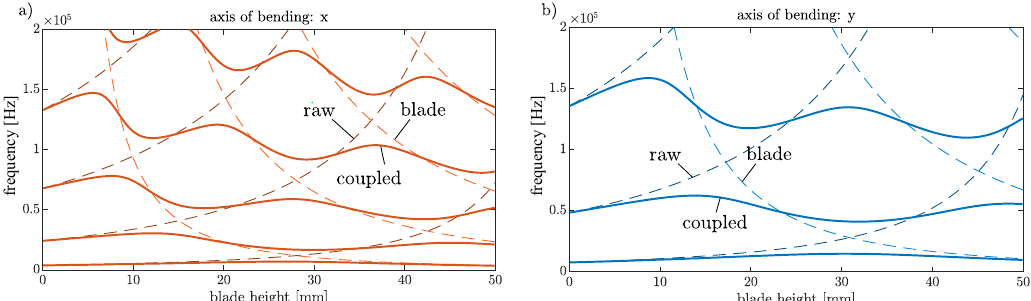
Figure 4. The fluctuation of the natural frequencies in the function of the blade height calculated by the simplified analytical model. Thick curves present the frequency fluctuations of the coupled part while thin curves represent the decomposed models. ( a ) bending vibration along the x axis ( b ) bending vibration along the y axis.